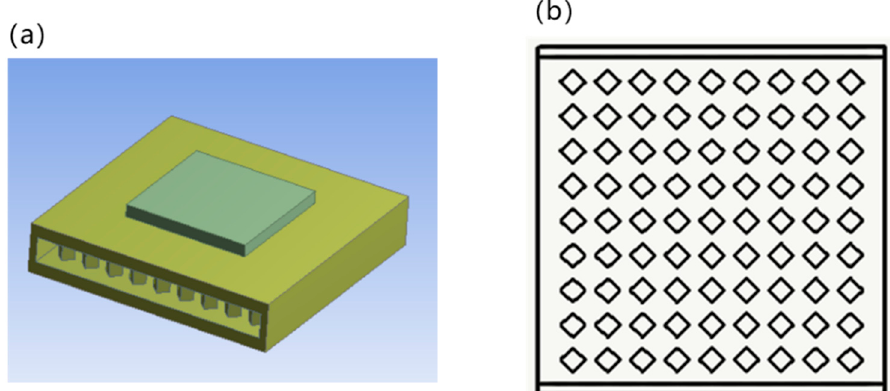
Figure 4. ( a ) Model of the heat dissipation system of the Pin-finned microchannel. ( b ) Schematic diagram of the top-view cross-sectional structure of the Pin-finned microchannel.